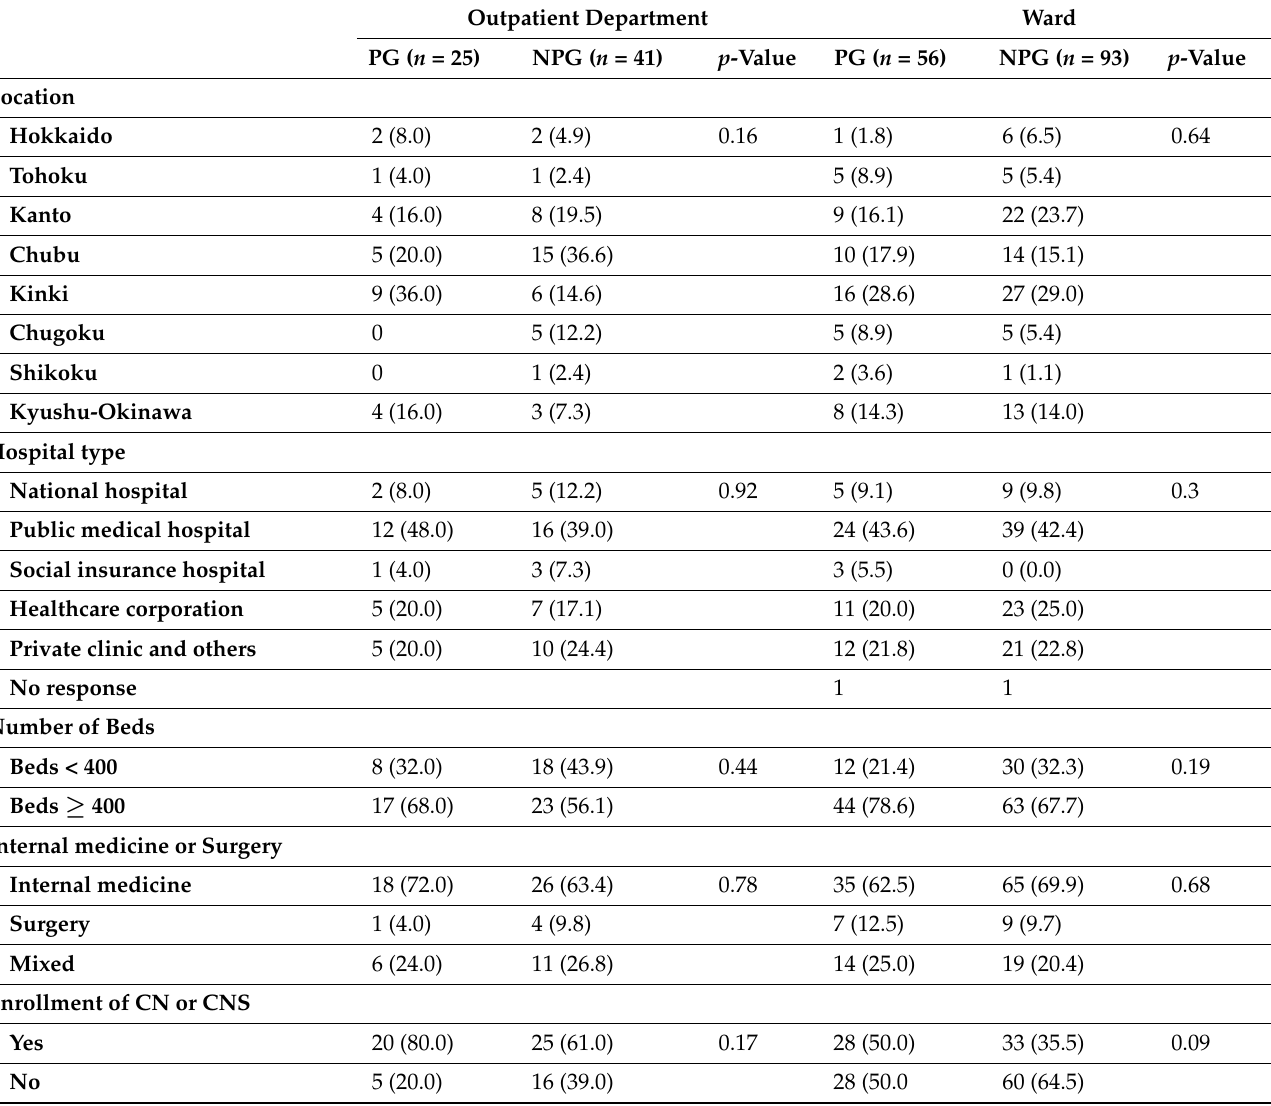
Table 2. Comparison between practice group and non-practice group in outpatient department and